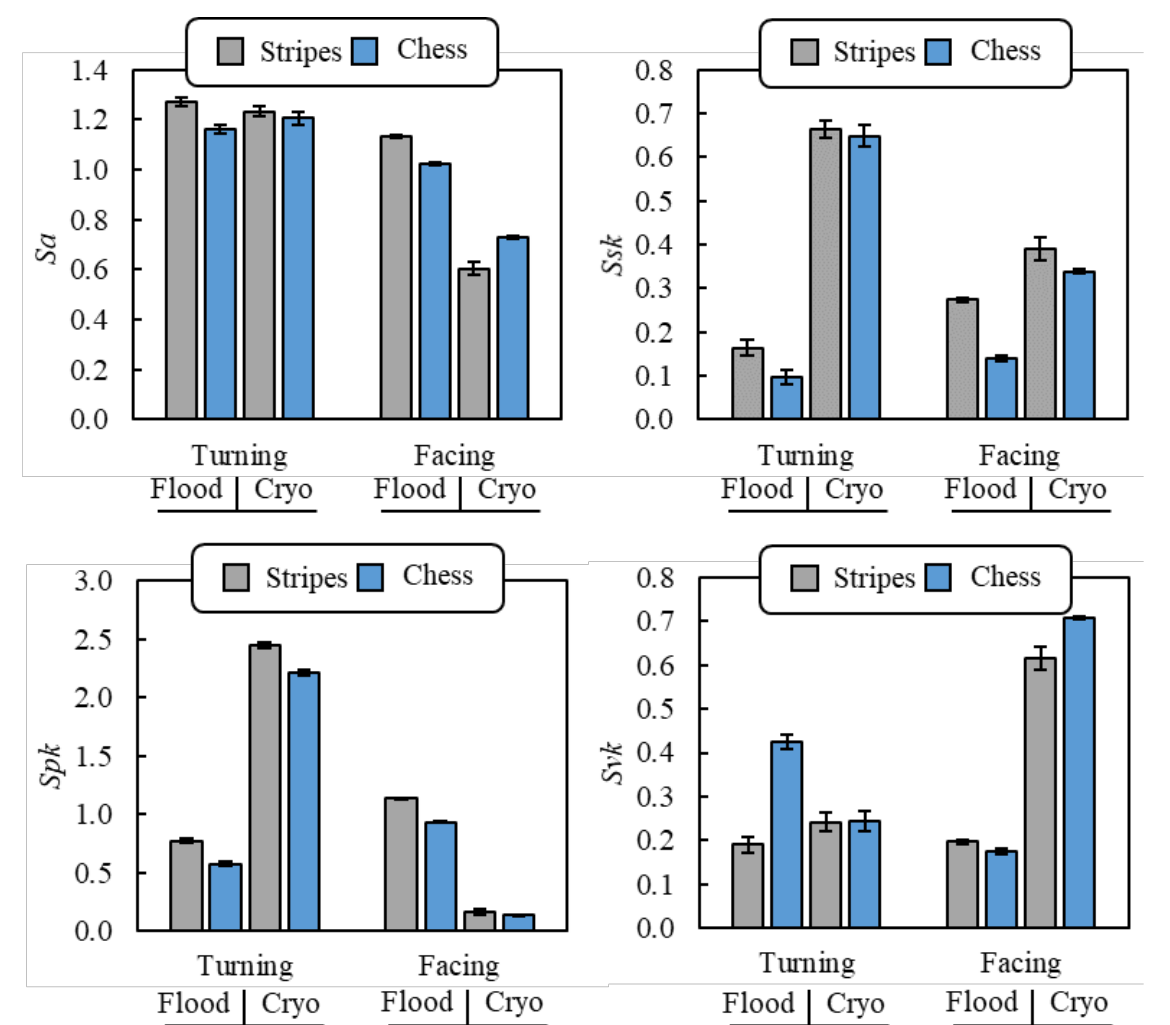
Figure 5. Surface roughness parameters of the machined surfaces.